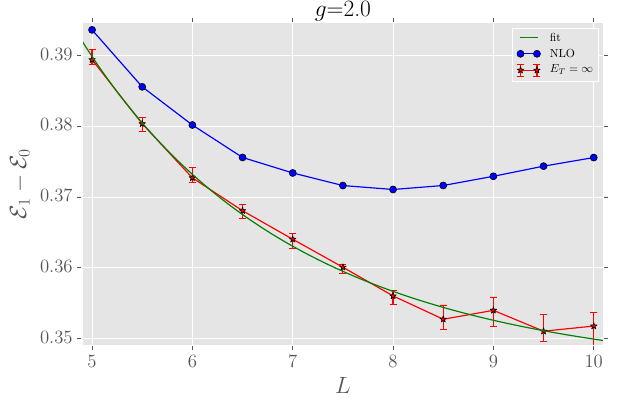
Figure 2 . The mass gap